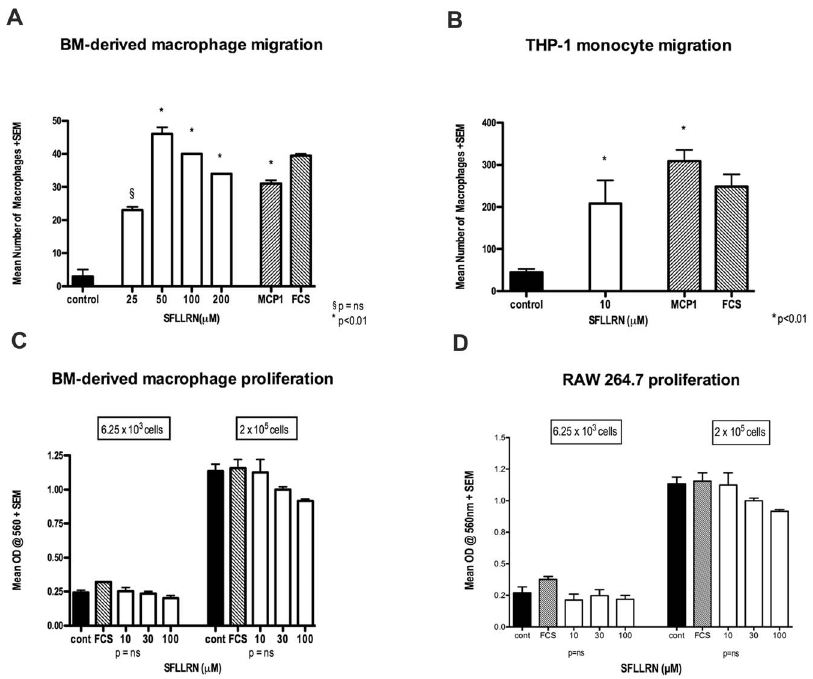
Figure 6. PAR1 activation induces monocyte/macrophage migration but not proliferation. (A–B) Migration assay of primary mouse BM- derived macrophages and a human monocyte cell line (THP-1) to SFLLRN demonstrating chemotaxis to the PAR1 agonist in both cell-types (MCP1 positive control). (C–D) SFLLRN has no pproliferative effect on primary mouse BM-derived macrophages (72 h) or a mouse macrophage cell line (RAW 264.7, 24 h) plated at the two different starting cell densities shown. (graphs show mean + SEM; p values as shown.)